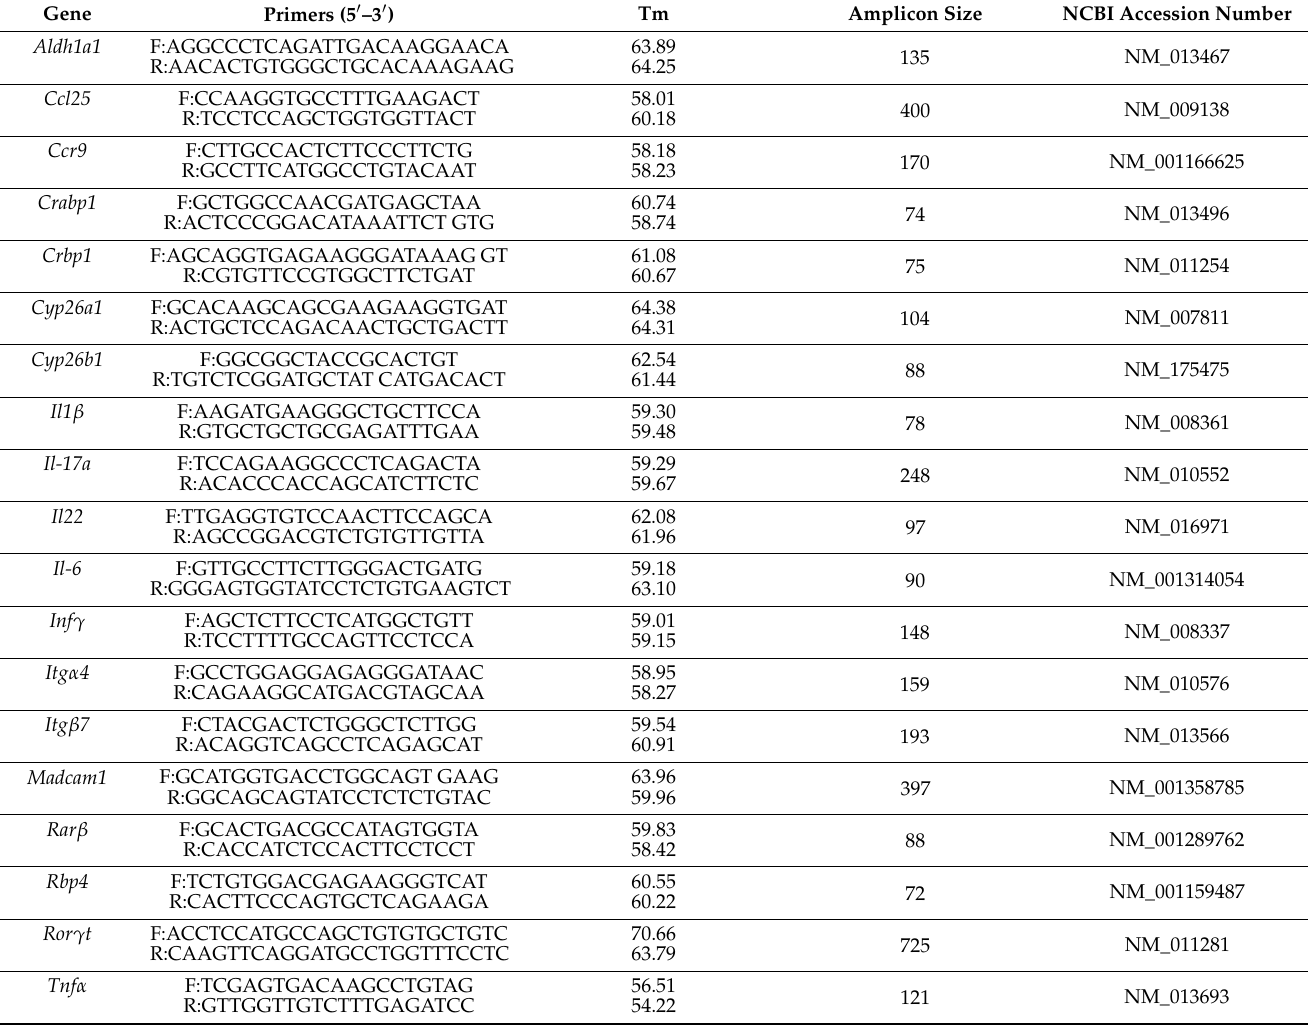
Table 3. Primers used for qPCR.